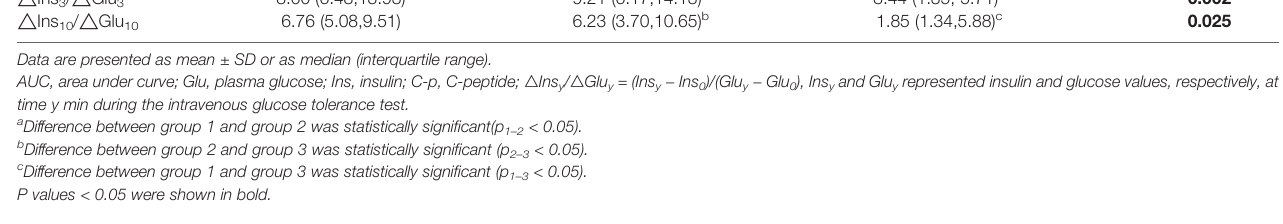
TABLE 2 | Comparison of IVGTT-based indices among three groups. Variables G1 (n = 21) p for linear trend